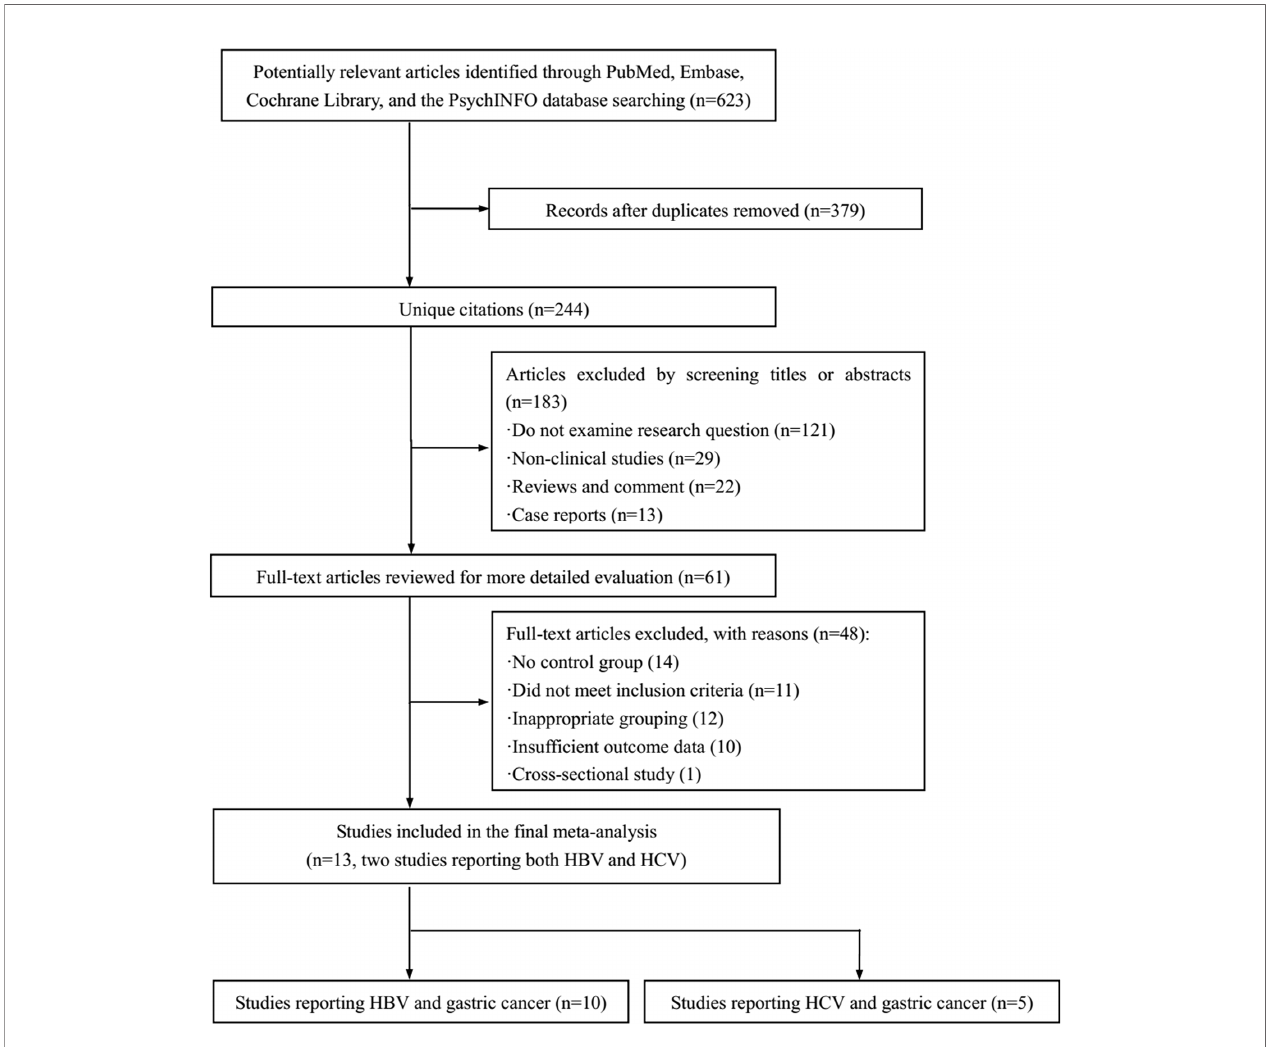
FIGURE 1 | Flow chart of study